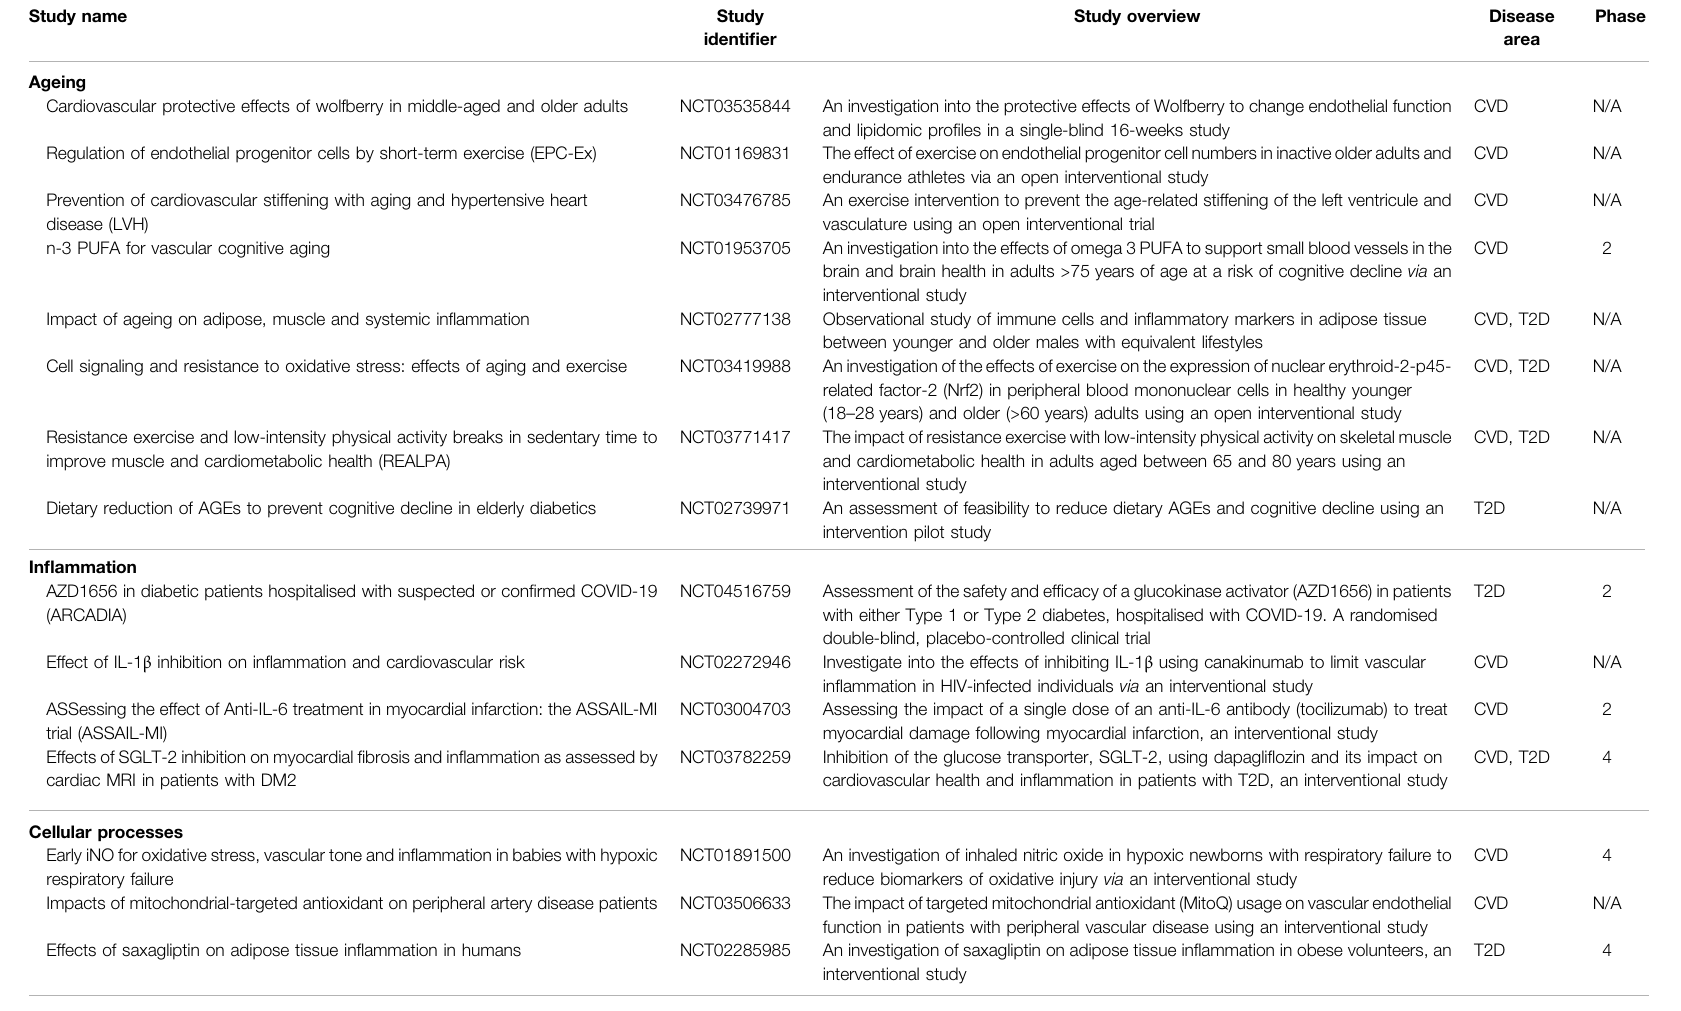
TABLE 1 | Examples of interventional trials in cardiovascular disease and T2D targeting ageing, in fl ammation and cellular phenotype [table adapted from (Hughes et al.,